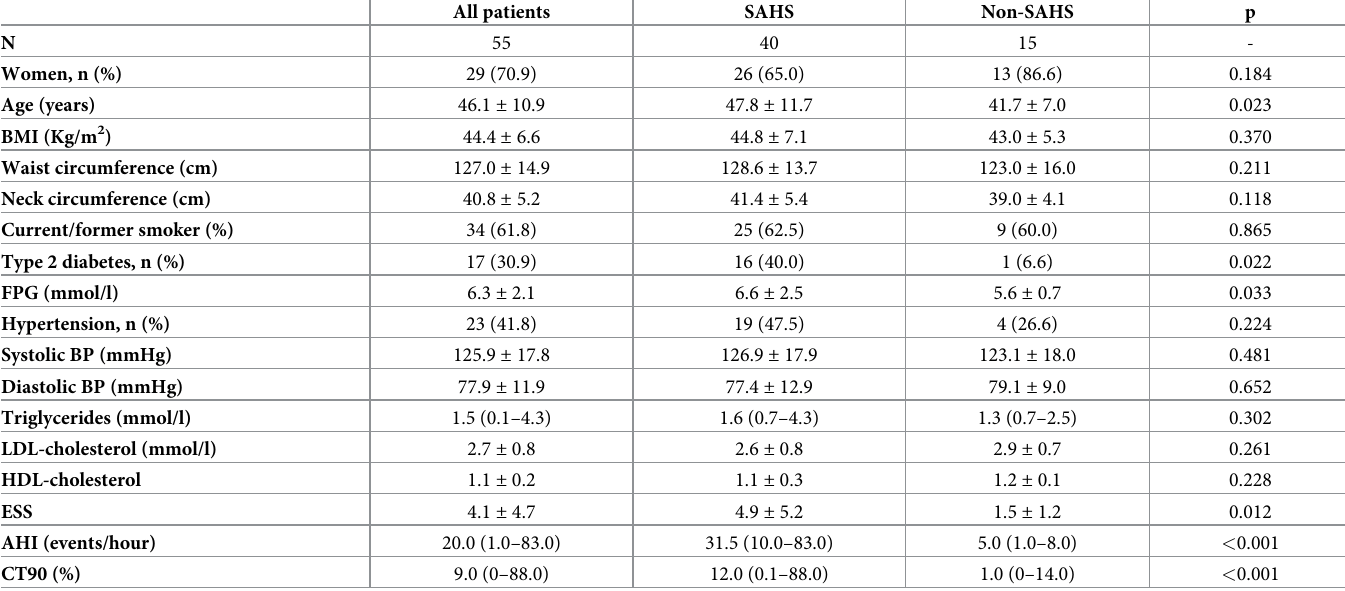
Table 1. Baseline main clinical, metabolic and sleep-breathing characteristics of participants in the study according to the diagnosis of sleep apnea-hypopnea syndrome. All patients